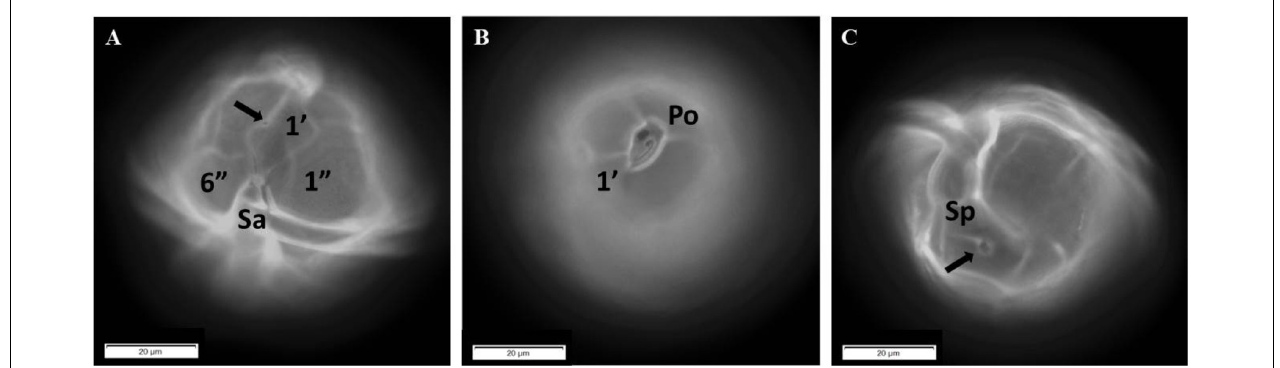
FIGURE 7 | Micrographs of Alexandrium tamiyavanichii in fluorescent microscopy showing some distinctive morphological characters. (A) Ventral view of a cell with the first apical plate (1 (cid:48) ), the first and sixth precingular plate (1 (cid:48)(cid:48) and 6 (cid:48)(cid:48) , respectively), and the anterior sulcal plate (Sa); the arrow points to the ventral pore. (B) Apical view showing the apical pore complex (Po) and the first apical plate (1 (cid:48) ). (C) Antapical view with the posterior sulcal plate (Sp) and its large pore (arrowed).